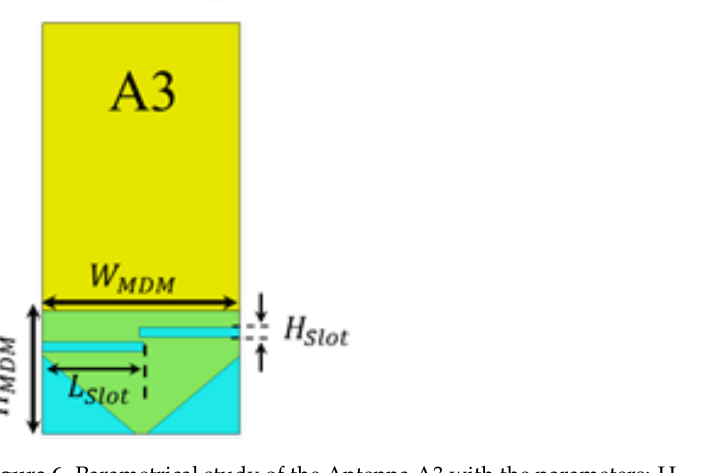
Figure 6. Parametrical study of the Antenna A3 with the parameters: H MDM , W MDM , L slot and H slot . The initial parameters are the following: W MDM = 96 mm, h MDM = 20 mm, L slot = 50 mm, H slot = 5